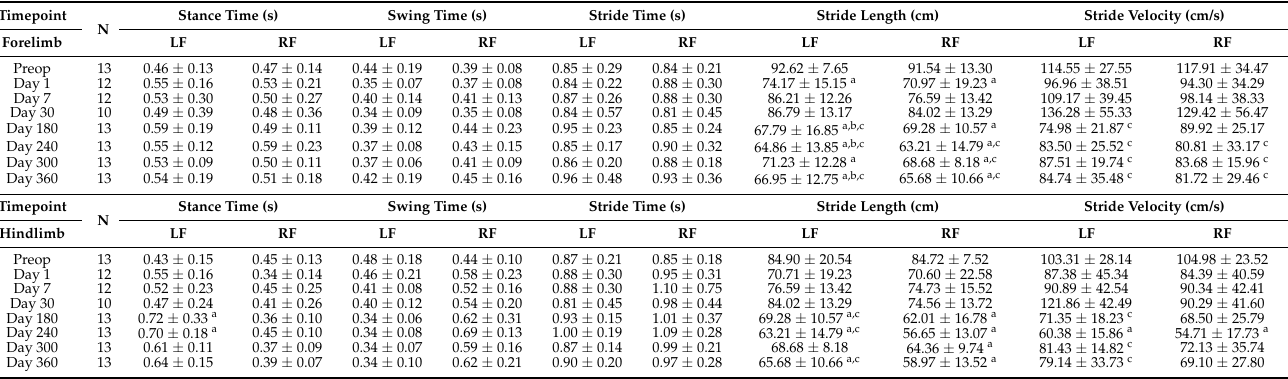
Table 1. Forelimb and hindlimb kinematics following right hindlimb tibial segmental defect locking plate stabilization and following right hindlimb cast immobilization. All values are presented as mean ± standard deviation.